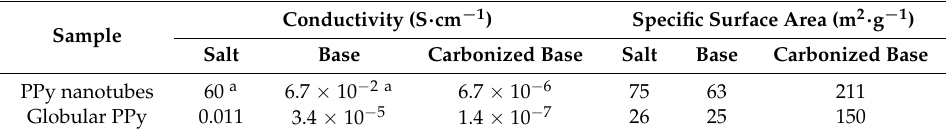
Table 1. Conductivity and specific surface area of globular and nanotubular PPy salts, bases, and their carbonized analogs.